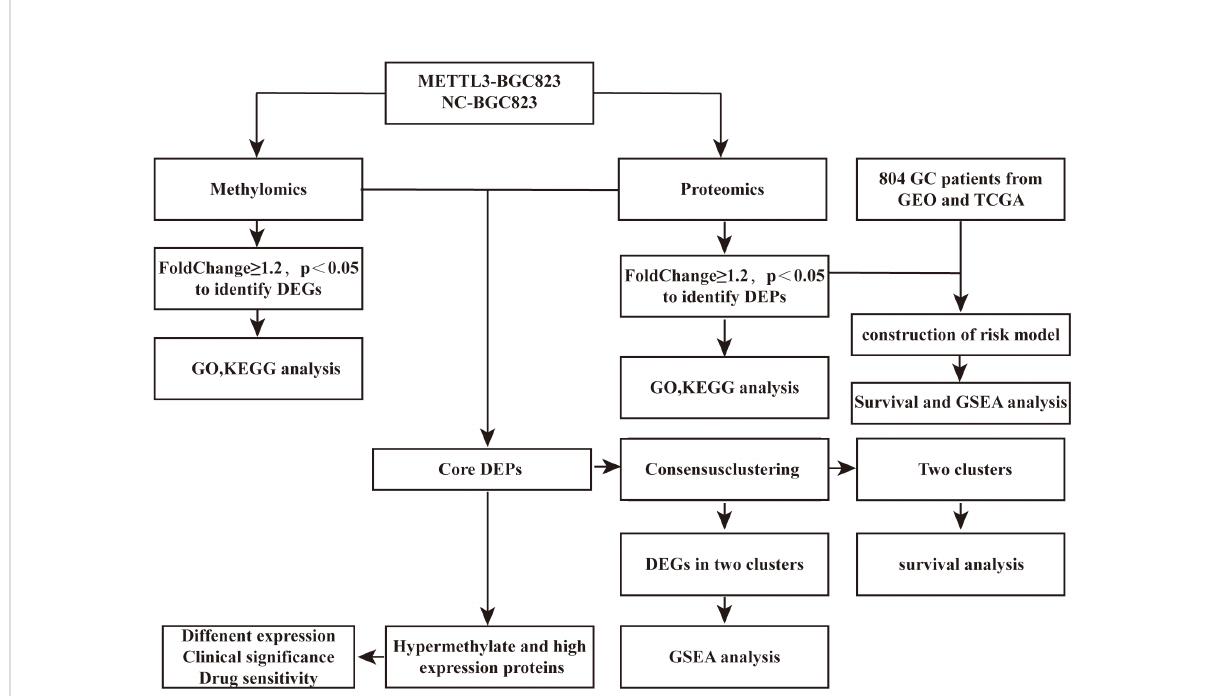
FIGURE 1 Flowchart depicting the process of this study. DEPs, differentially expressed proteins; DMGs, differential methylation genes; DEGs, differentially expressed